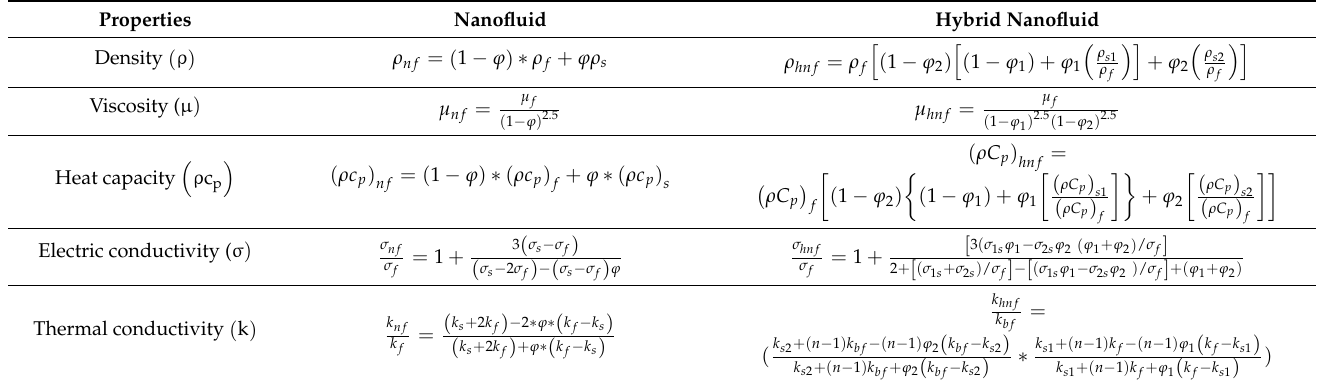
Table 4. The relations of the thermo-physical properties of the nanofluids and hybrid nanofluids [1,8,16,17,56].